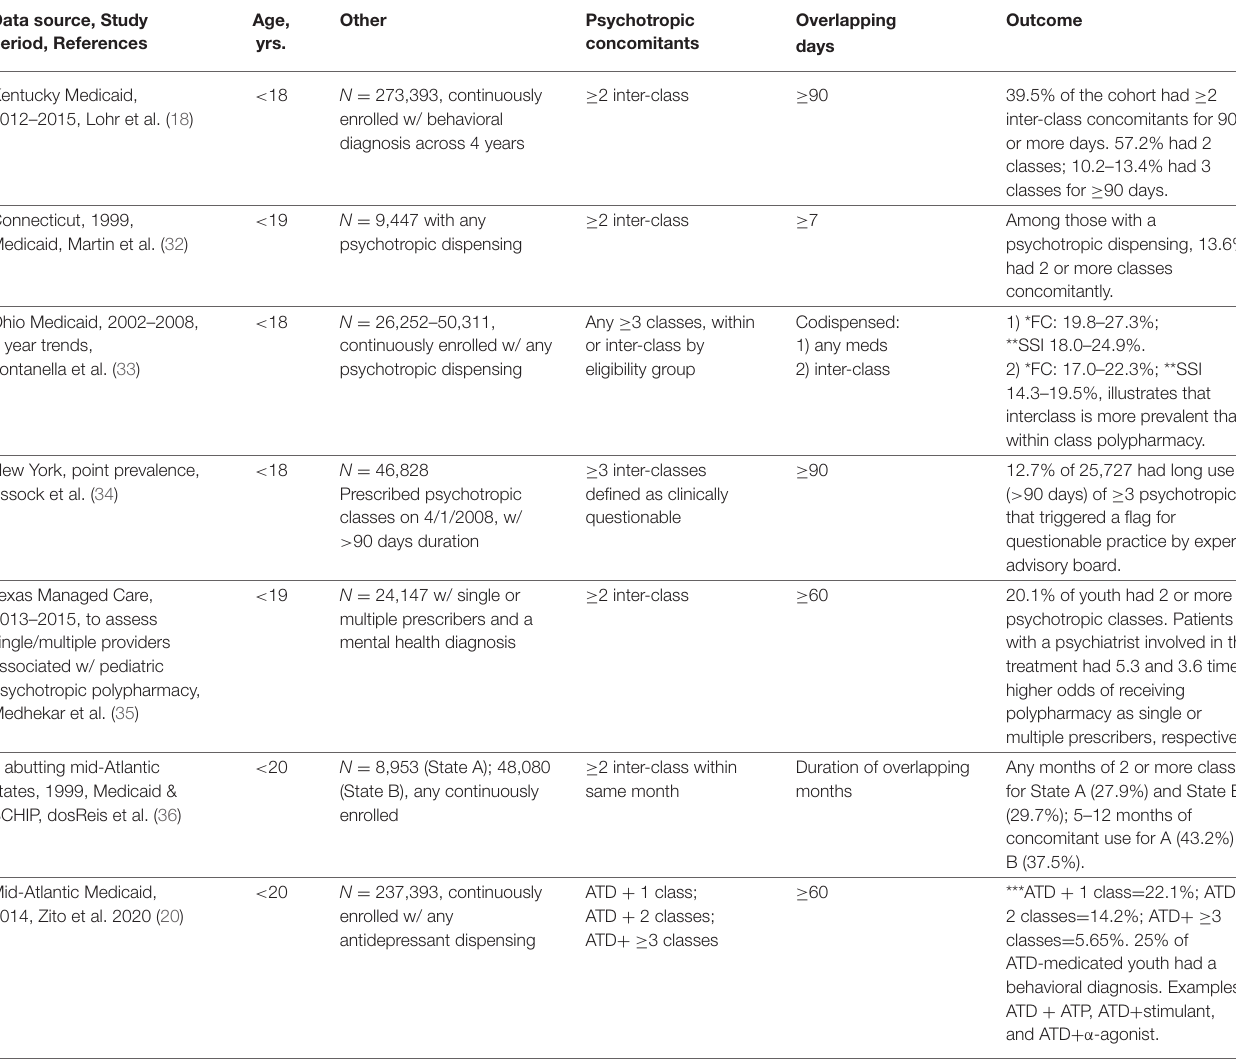
TABLE 2b | Single/two state medicaid pediatric psychotropic polypharmacy studies using state-based data. Data source, Study period,